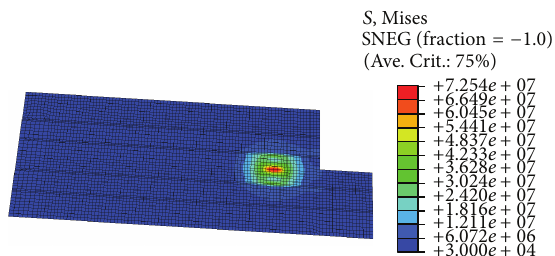
Figure 10: The model for finite element analysis of the ECCS vessel support (vertical position in